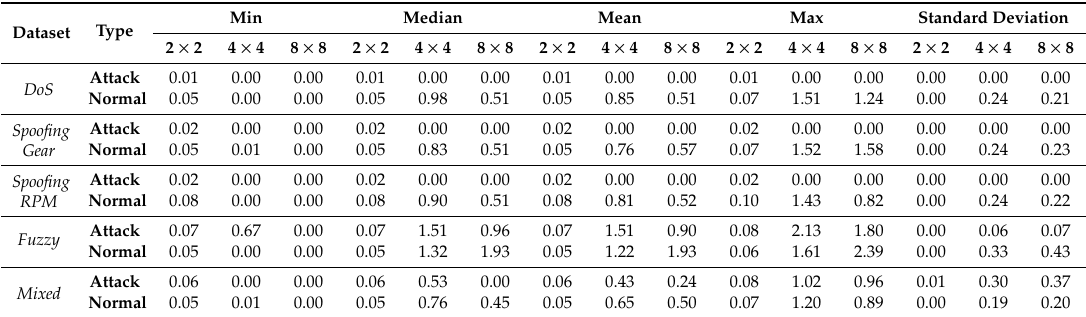
Table 7. Evaluation metrics for the XYF–K